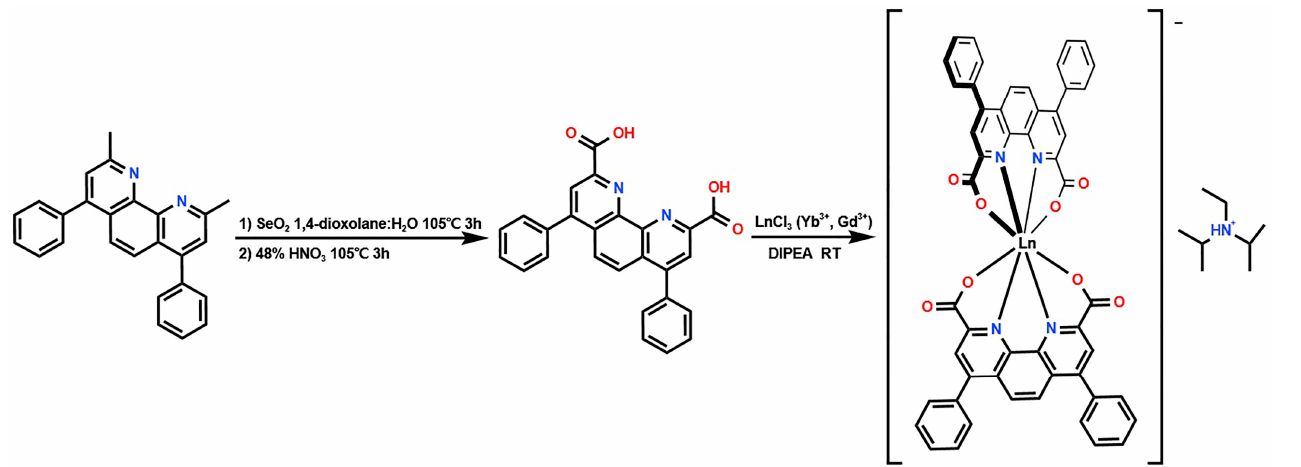
Scheme 1. The synthetic routes of the ligand DPPDA and the Ln complexes [Ln(DPPDA) 2 ](DIPEA).